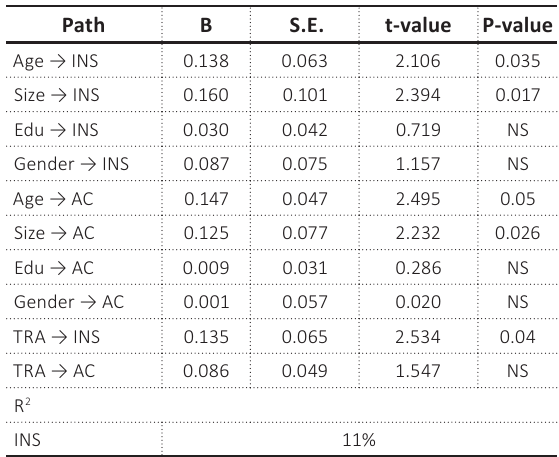
Table 6. Structural model results of Model 1